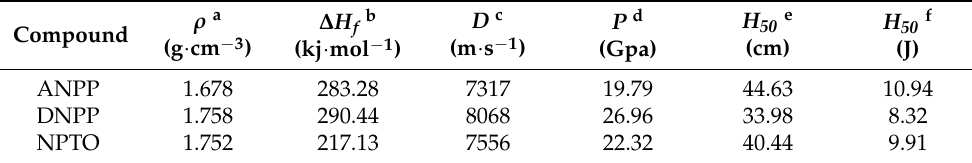
Table 3. Calculated physico-chemical properties and detonation parameters of NPTO.